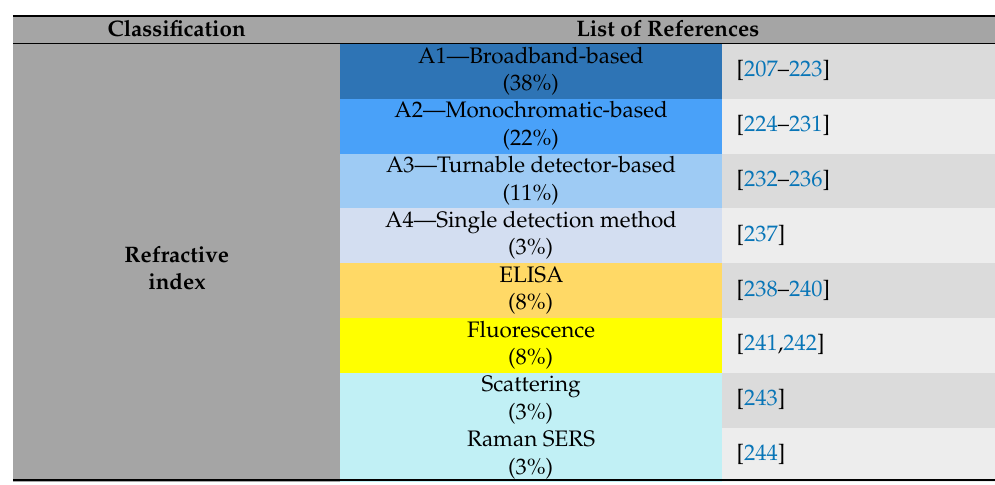
Figure 17. Classification of the linked patents. Table 2. Classification of the Patents included in the study according to their categories and their